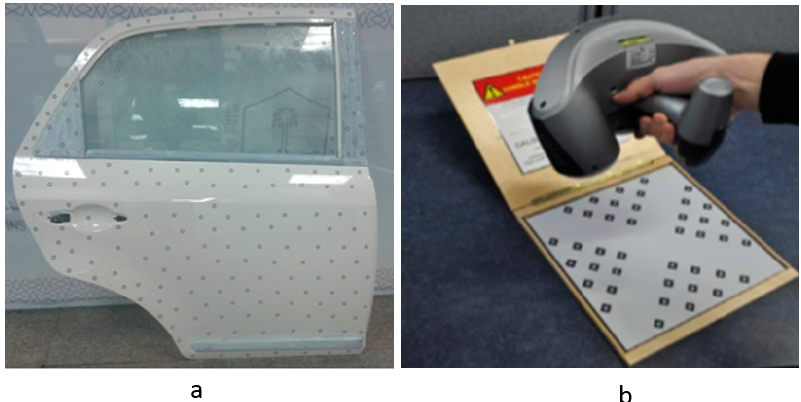
Figure 4. ( a ) Car door with positioning targets; ( b ) Calibration of the scanner.